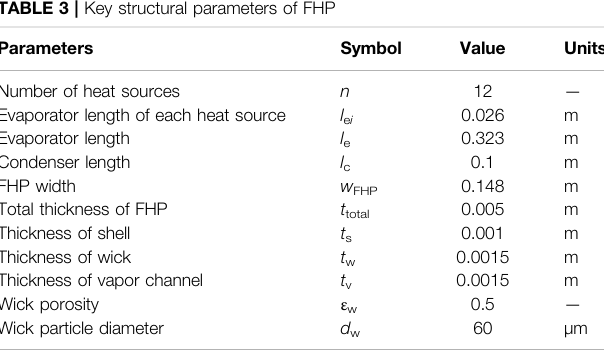
TABLE 3 | Key structural parameters of FHP